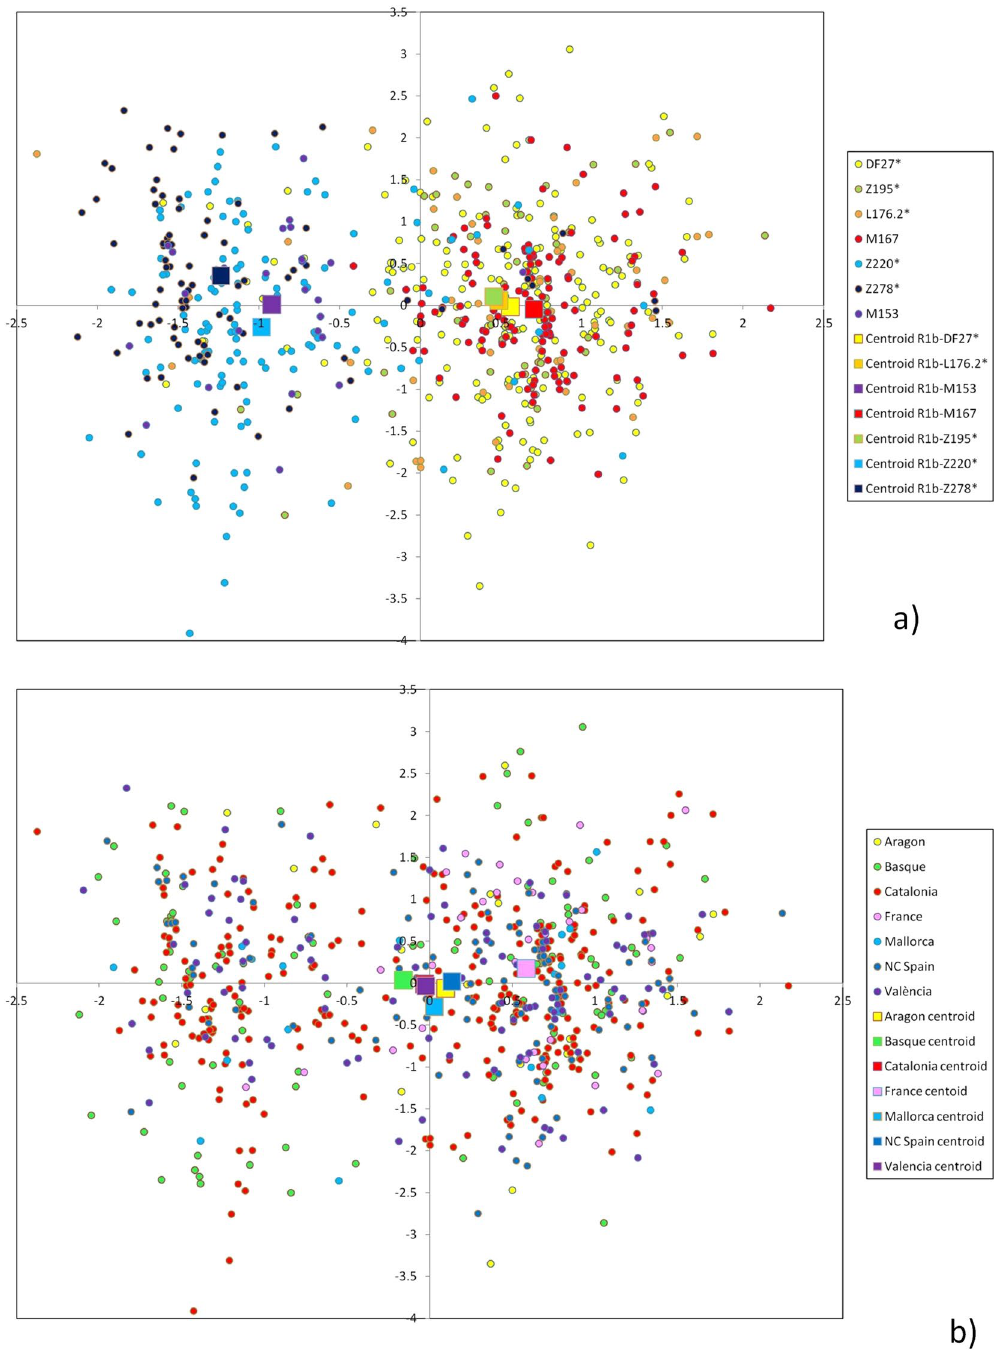
Figure 4. Principal component analysis of STR haplotypes. ( a ) Colored by subhaplogroup, ( b ) colored by population. Larger squares represent subhaplogroup or population